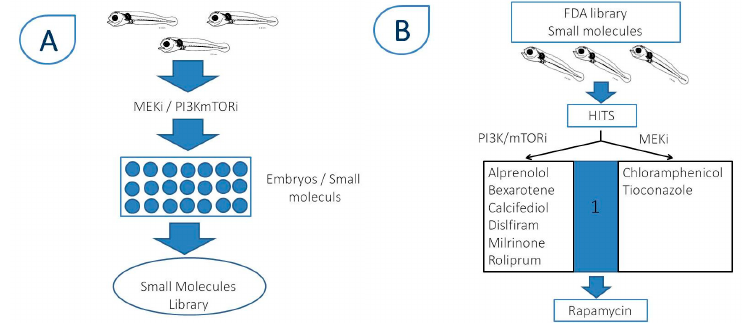
Figure 4. Drug development and inhibitor screening using selected MEKi and PI3K/mTOR inhibitors. Zebrafish plays an important role for the screening of compounds targeting MEK/ERK and PI3K/mTOR pathways, both alone and in combination. ( A ) Example of screening of the FDA library molecules using zebrafish embryos; ( B ) steps showing hit selection after the screening procedure with different drugs and drug dose response using the melanin assay. At the end of this process, 11 hits were detected to be further evaluated in cell culture. MEKi: mitogen-activated protein kinases inhibitor; PI3K: phosphoinositide 3-kinase; mTOR: mechanistic target of rapamycin.